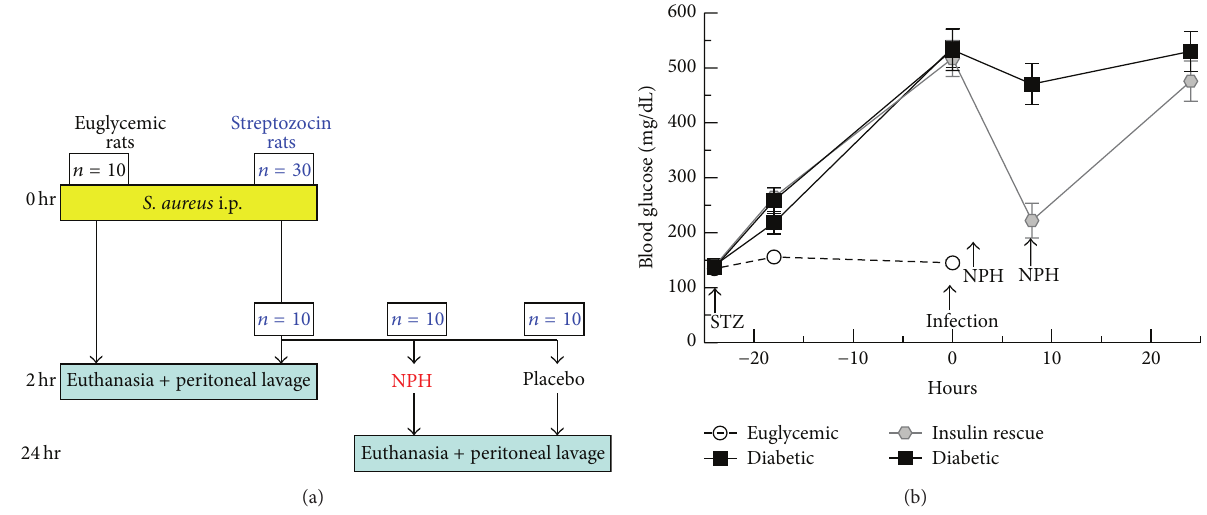
Figure 1: (a) Rat treatment groups and timeline for streptozocin induction, infection, insulin rescue (NPH), and peritoneal lavage. (b) Blood glucose levels for the four groups of rats: euglycemic, diabetic (2 hr), insulin rescue, and diabetic (24hr). Streptozocin (STZ) was given to all rats except the euglycemic group at − 24 hours. Zero hour is time of infection. Insulin (NPH) was given to the insulin rescue group at 2 hours and 8 hours after